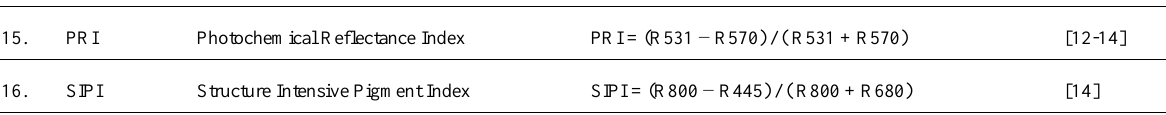
indicates the reflectance at a xxx